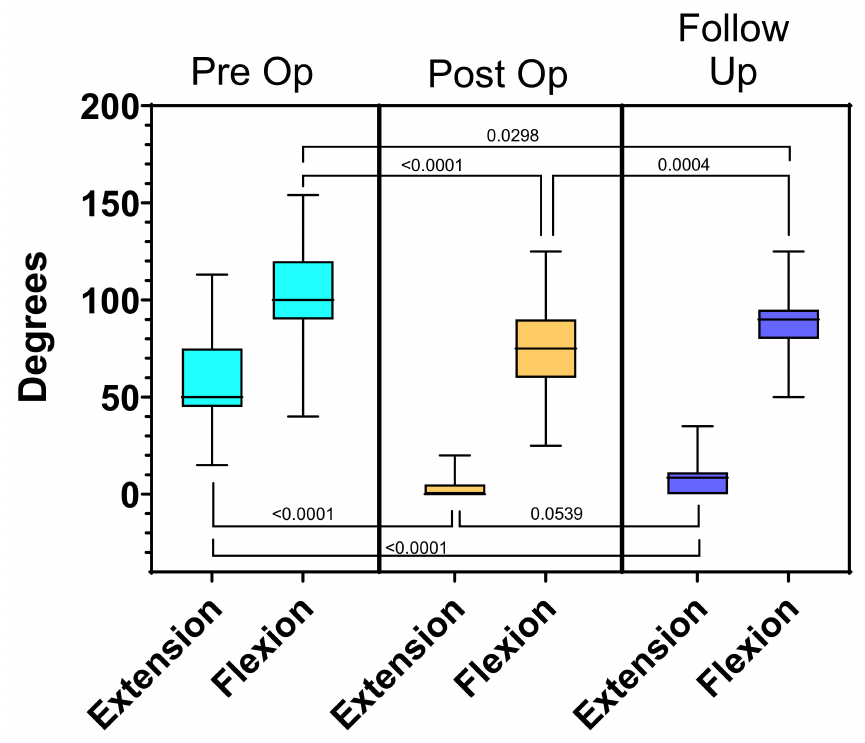
Figure 13. Demonstrates the flexion and extension values pre-operatively, post-operatively, and at follow up. The overall range of motion increased but the arc of motion also was shifted to a more functional